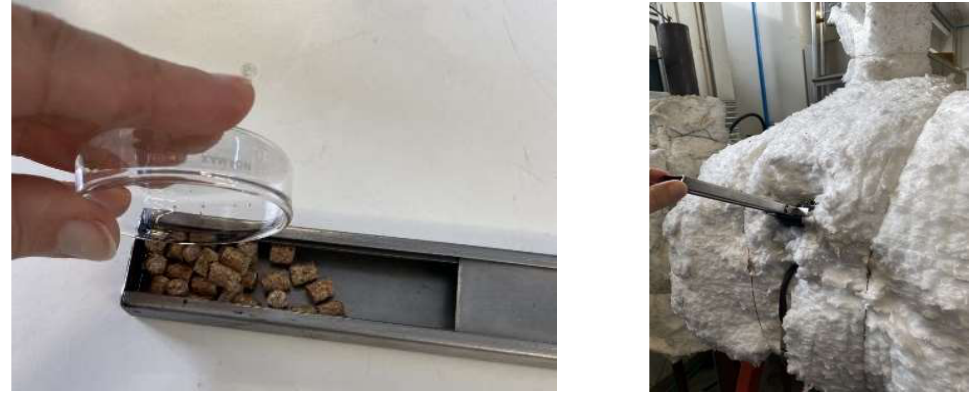
Figure 4. Batches feeding